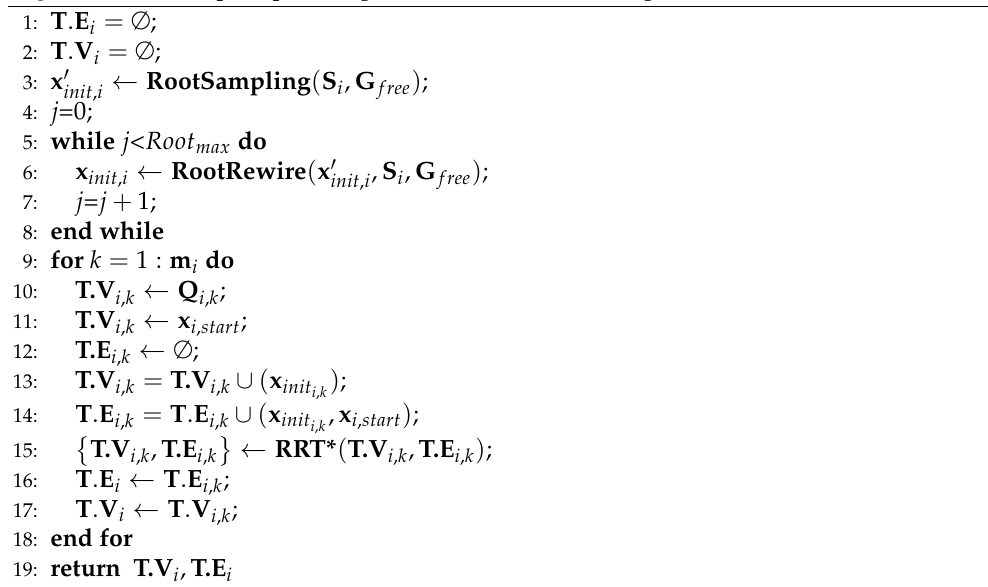
Algorithm 1 Local path planning based on RRT-MRNC